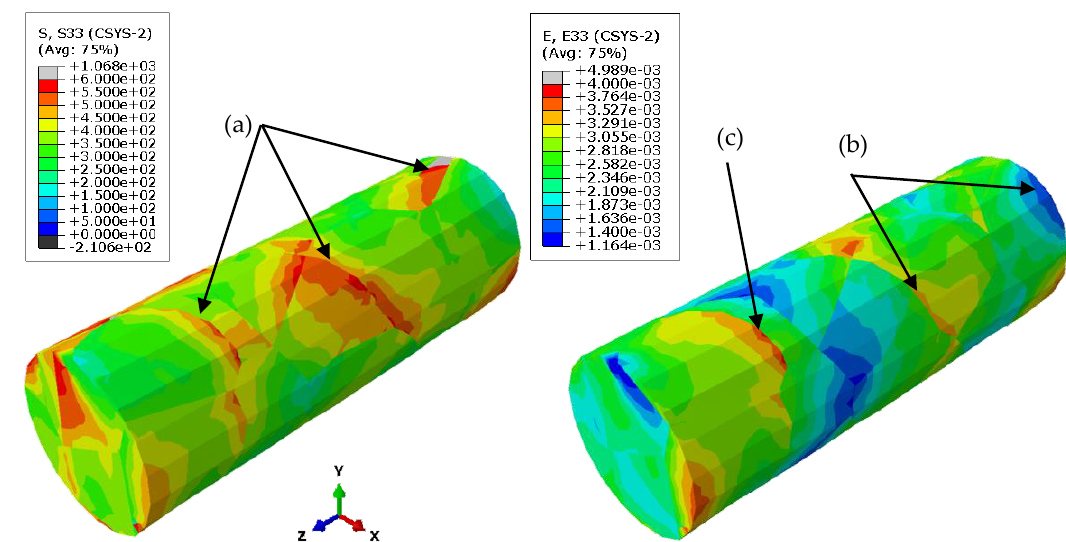
Metals 2019 , 9 , 813 13 of 28